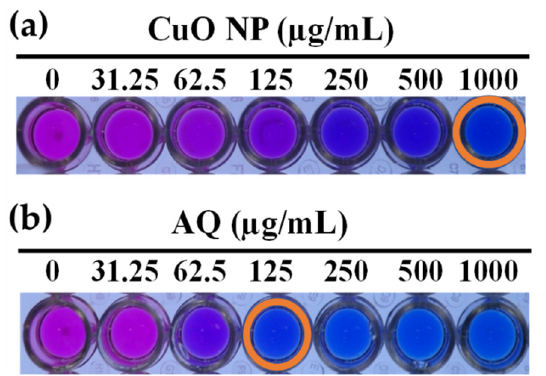
Figure 4. Measurement of the ( a ) zeta potential and ( b ) size of CuO NPs. The zeta potential of both original samples from the synthesis and 1 month after synthesis was measured. Data are shown as the mean ± SD ( n = 3; p < 0.05).